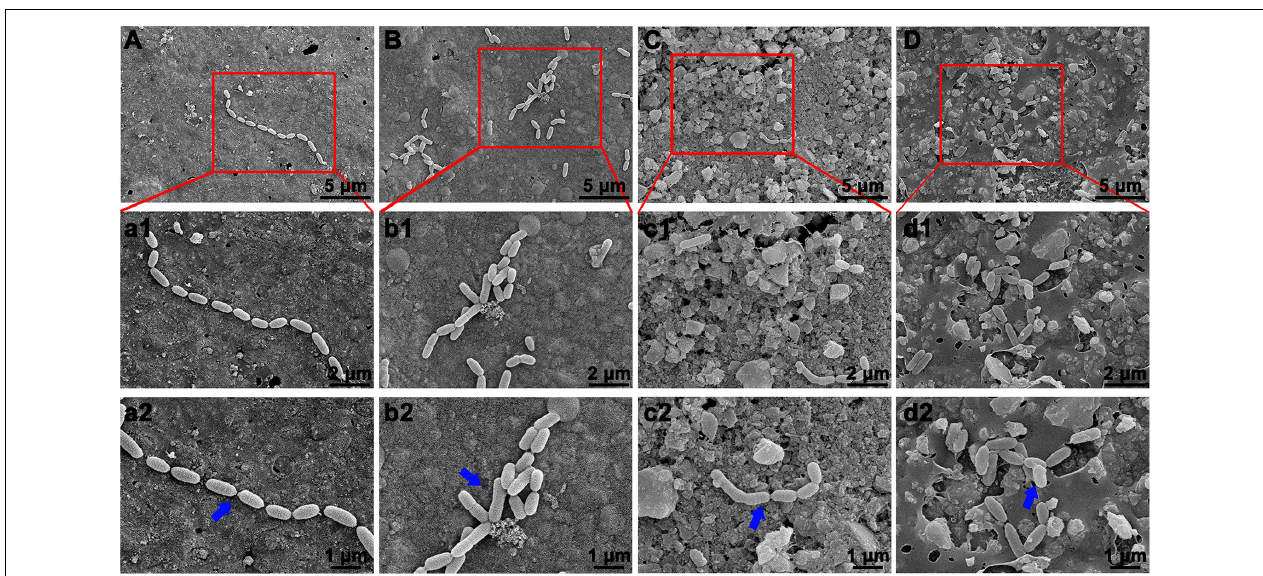
FIGURE 8 | Bacterial morphology of S. mutans on surface of BAG-modified composite resin detected by scanning electron microscope (SEM). (A,a1,a2) BAG0 group; (B,b1,b2) BAG8 group; (C,c1,c2) BAG16 group; (D,d1,d2) BAG23 group. (A–D) Overall bacterial morphology (scale bar: 10 µ m). (a1–d1, a2–d2) Higher magnification of the red box area in panels (A–D) ( a1–d1 , scale bar: 5 µ m; a2–d2 , scale bar: 3 µ m). The blue arrow indicates S. mutans . BAG0 indicates composite resin without BAG; BAG8 indicates composite resin with 8 wt% BAG; BAG16 indicates composite resin with 16 wt% BAG; BAG23 indicates composite resin with 23 wt%